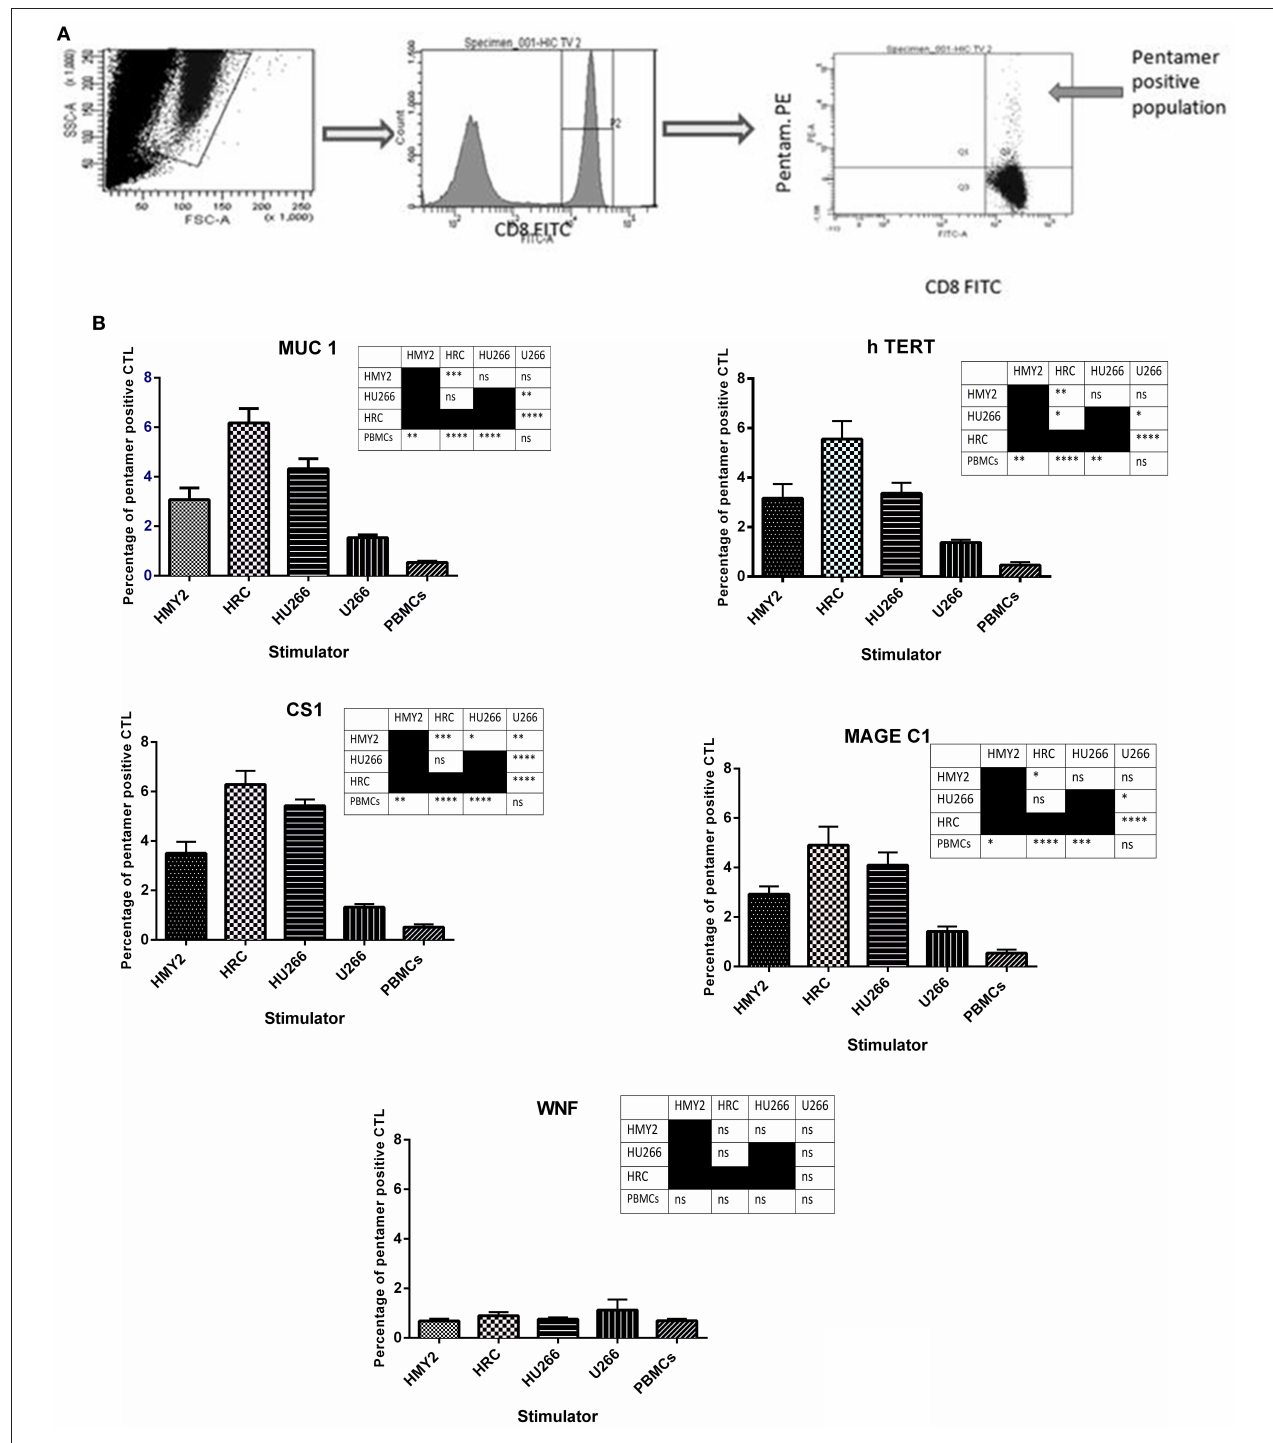
FIGURE 3 | Presence of tumor antigen-specific CD8 + T cells in cultures, using HLA-A2-peptide pentamer staining. (A) Sequential gating on the live T cells using SSC X FSC dot plot, followed by gating the CD8 + population, and finally determining the percentage of the double positive CD8 + pentamer + T cells on the FITC vs. PE dot plot. (B) Percentages of positive MUC1, h TERT, CS1, MAGE-C1, and WNF HLA-A*0201 restricted, HLA-A2-peptide pentamer-stained CTL. The CTL were generated by four rounds of stimulation of PBMCs isolated from five HLA-A2 + patients, using the hybrid cell lines, HRC and HU266, or the parent cell lines HMY2 and U266 as stimulators. The percentages were determined using flow cytometric analysis. Results are presented as mean ± SEM. The levels of significance have been summarized in the table next to each chart and presented as asterisks (* p < 0.05, ** p ≤ 0.01, *** p ≤ 0.001, and **** p ≤ 0.0001).